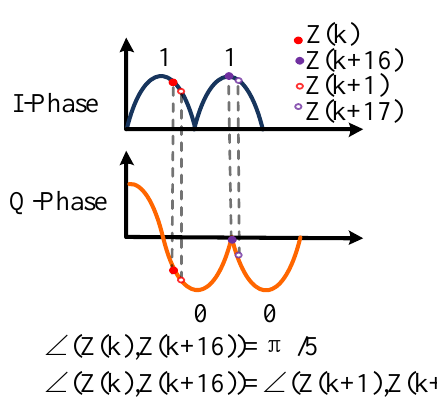
Figure 6. Analysis of (cid:93) ( Z ( k ) , Z ( k + 16 )) : chips are the